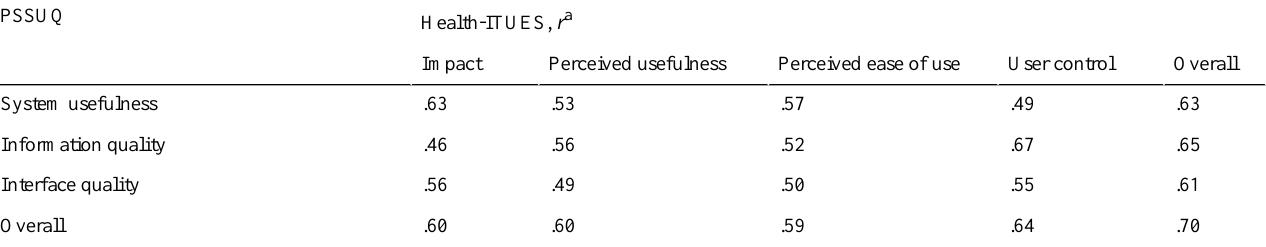
Table 5. Correlations between Health-ITUES and PSSUQ subscales (N=83).